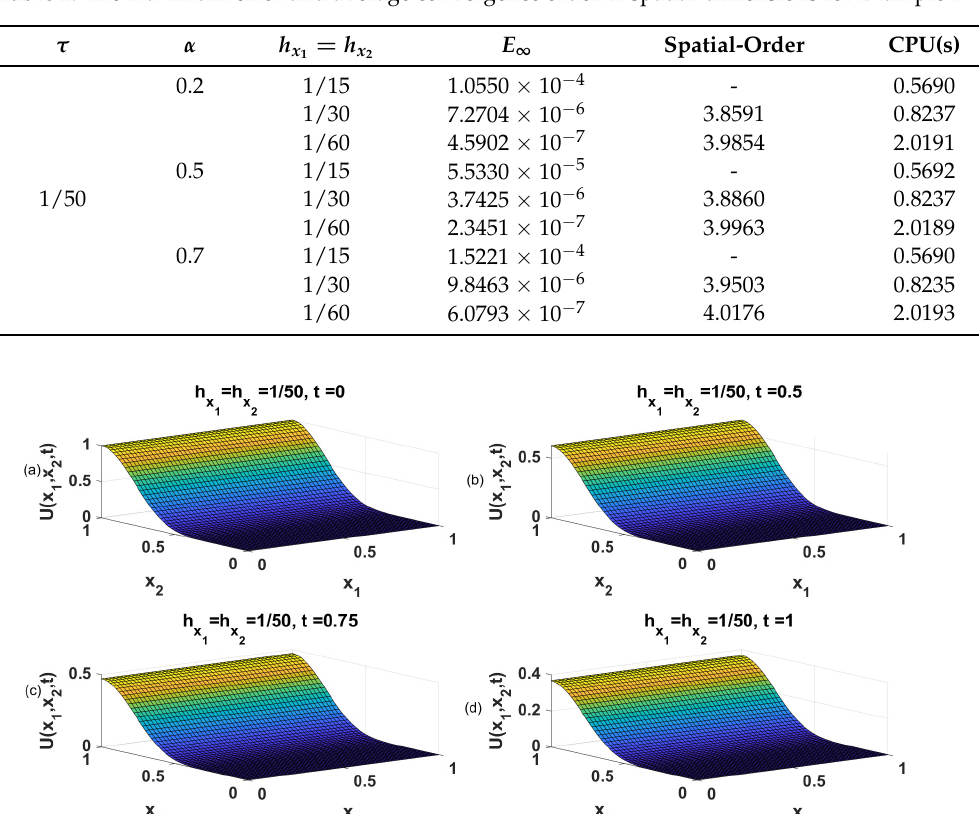
Table 2. The maximum error and average convergence order in spatial-dimensions for Example 1.